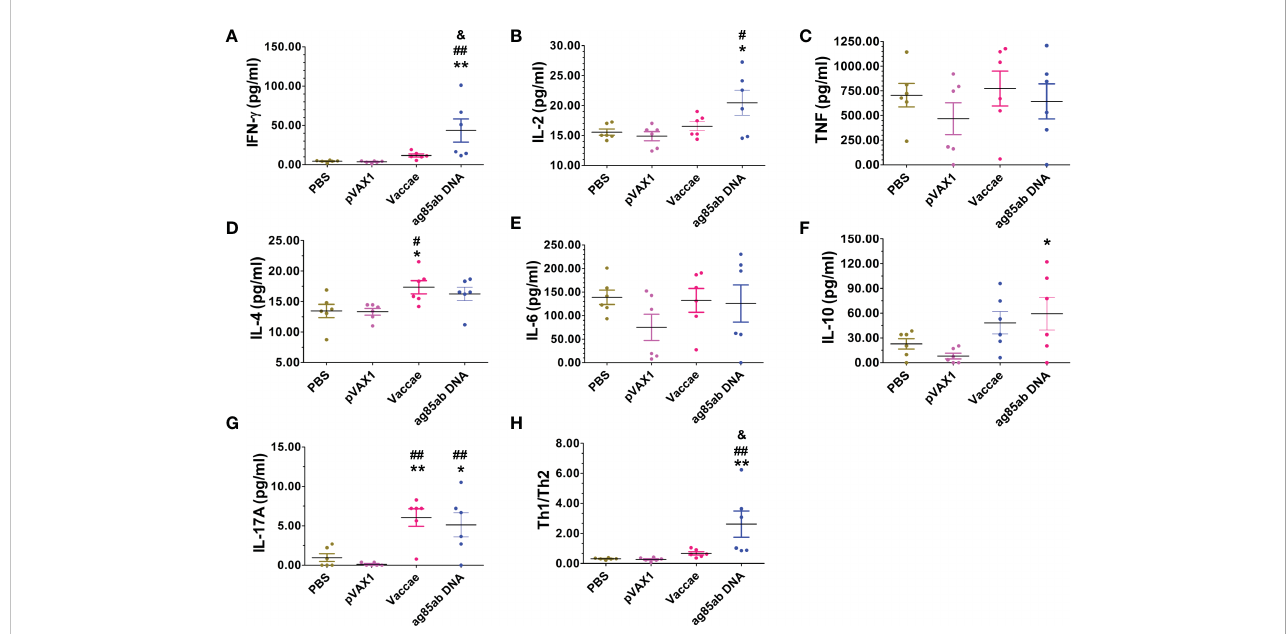
FIGURE 6 The levels of IFN- g , IL-2, TNF- a , IL-4, IL-6, IL-10 and IL-17A cytokines in the splenocyte culture supernatant in response to recombinant Ag85AB protein for 72hrs were detected with a Mouse Th1/Th2/Th17 Cytokine Kit. (A) IFN- g (pg/ml), (B) IL-2 (pg/ml), (C) TNF (pg/ml), (D) IL-4 (pg/ml), (E) IL-6 (pg/ml), (F) IL-10 (pg/ml), (G) IL-17A (pg/ml), (H) Th1/Th2. Compared with PBS group: * P < 0.05, ** P < 0.01; Compared with vector group: # P < 0.05, ## P < 0.01; Compared with Vaccae vaccine group: & P <